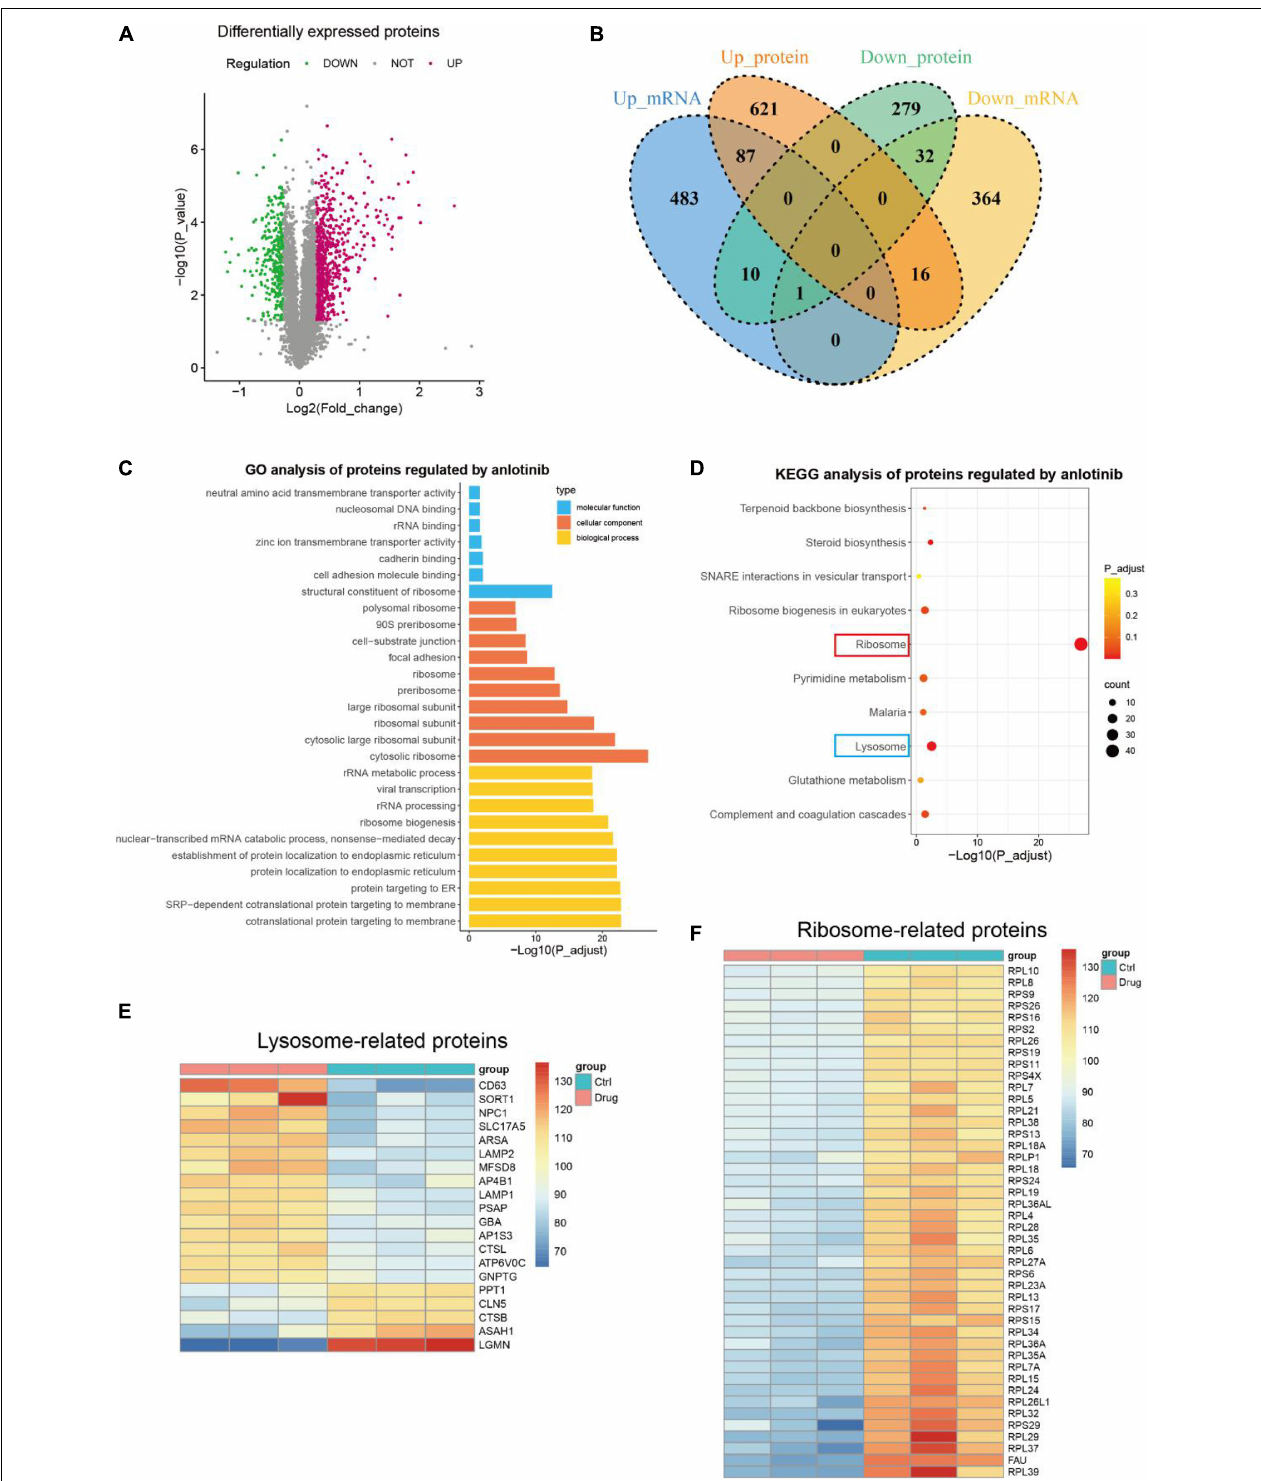
FIGURE 3 | Proteomics profiling. (A) The volcano plot of differentially expressed proteins of PANC-1 cells treated with anlotinib. (B) The venn plot of DEGs and differentially expressed proteins of PANC-1 cells treated with anlotinib. (C,D) GO (C) and KEGG (D) analysis of differentially expressed proteins of PANC-1 cells treated with anlotinib. (E) The heatmap of differentially expressed proteins related to lysosome . (F) The heatmap of differentially expressed proteins related to ribosome .